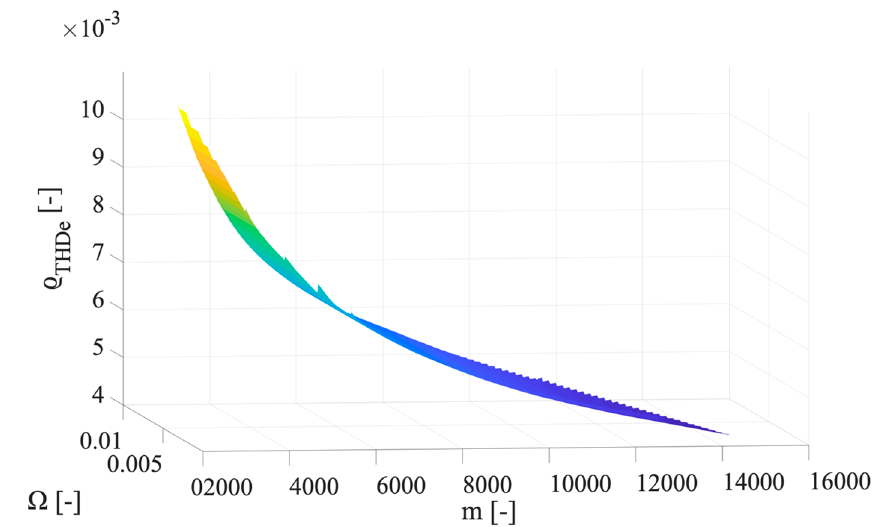
Figure 5. Graph of 𝜚 (cid:3021)(cid:3009)(cid:3005)_(cid:3032) values vs. 𝑚 and 𝛺 , for the accuracy class 0.2.